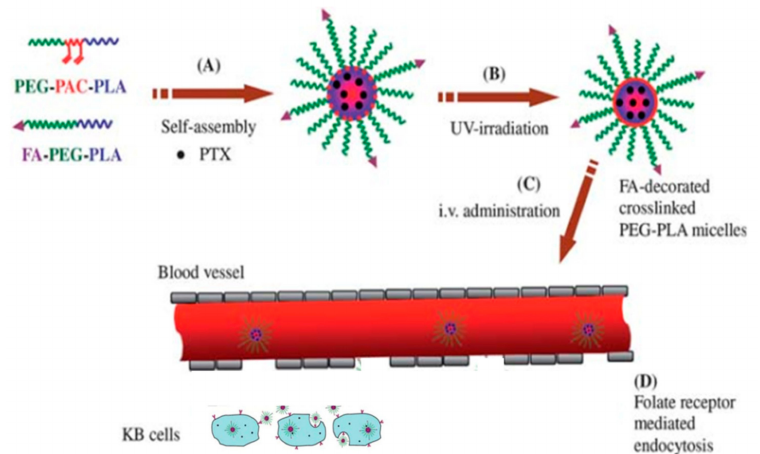
Figure 8. Illustration of folate-conjugated interfacially crosslinked biodegradable micelles for targeted delivery of paclitaxel